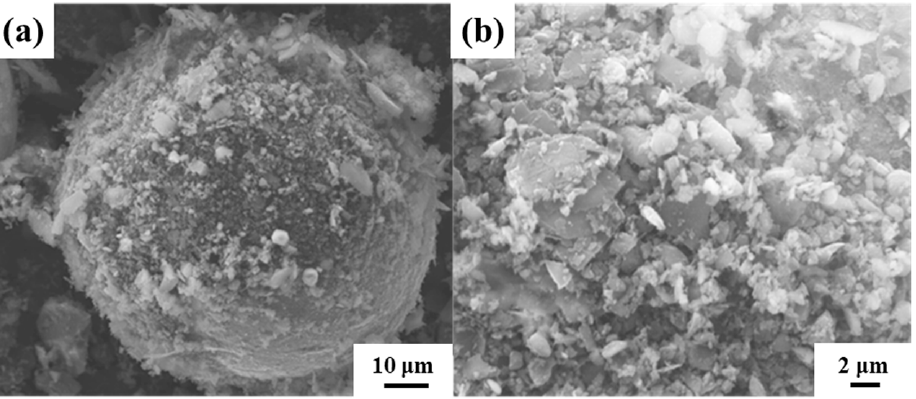
Figure 4. SEM characterization of core-shell Ti-B 4 C (30 vol.%). ( a ) Core-shell Ti-B 4 C, ( b ) the local amplification results of ( a ).